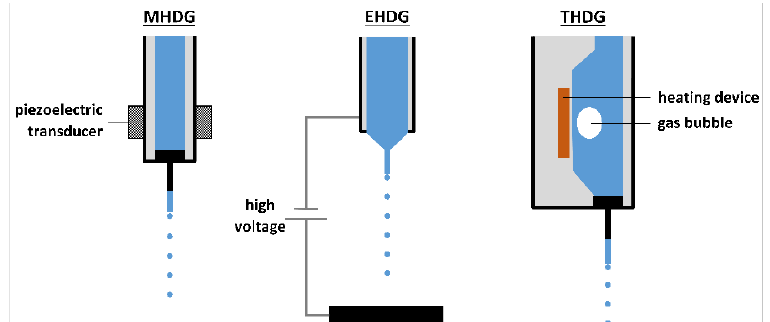
Figure 3. Schematic illustration of a mechano-hydrodynamic droplet generator (MHDG) equipped with a piezoelectric transducer, an electro-hydrodynamic droplet generator (EHDG) in (micro)dripping mode and a thermo-hydrodynamic droplet generator (THDG) (modified from Liu et al. [31]).